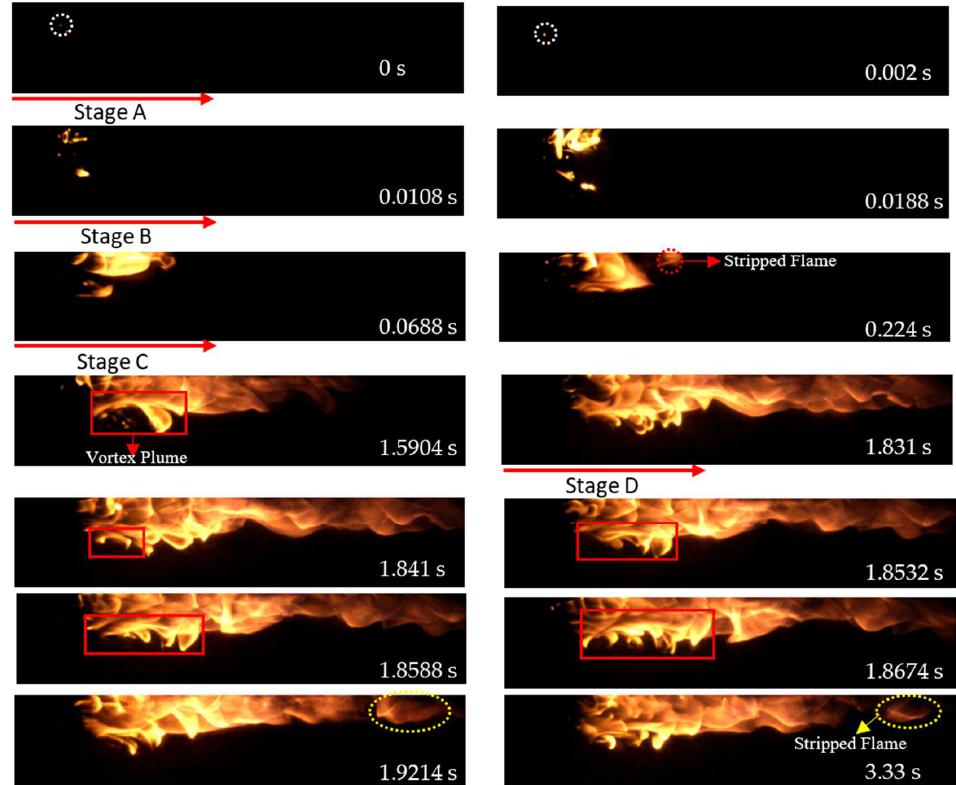
Figure 4. Flame propagation under the air flow velocity of 1.4 m/s and the diesel flow rate of 10.0 mL/min.